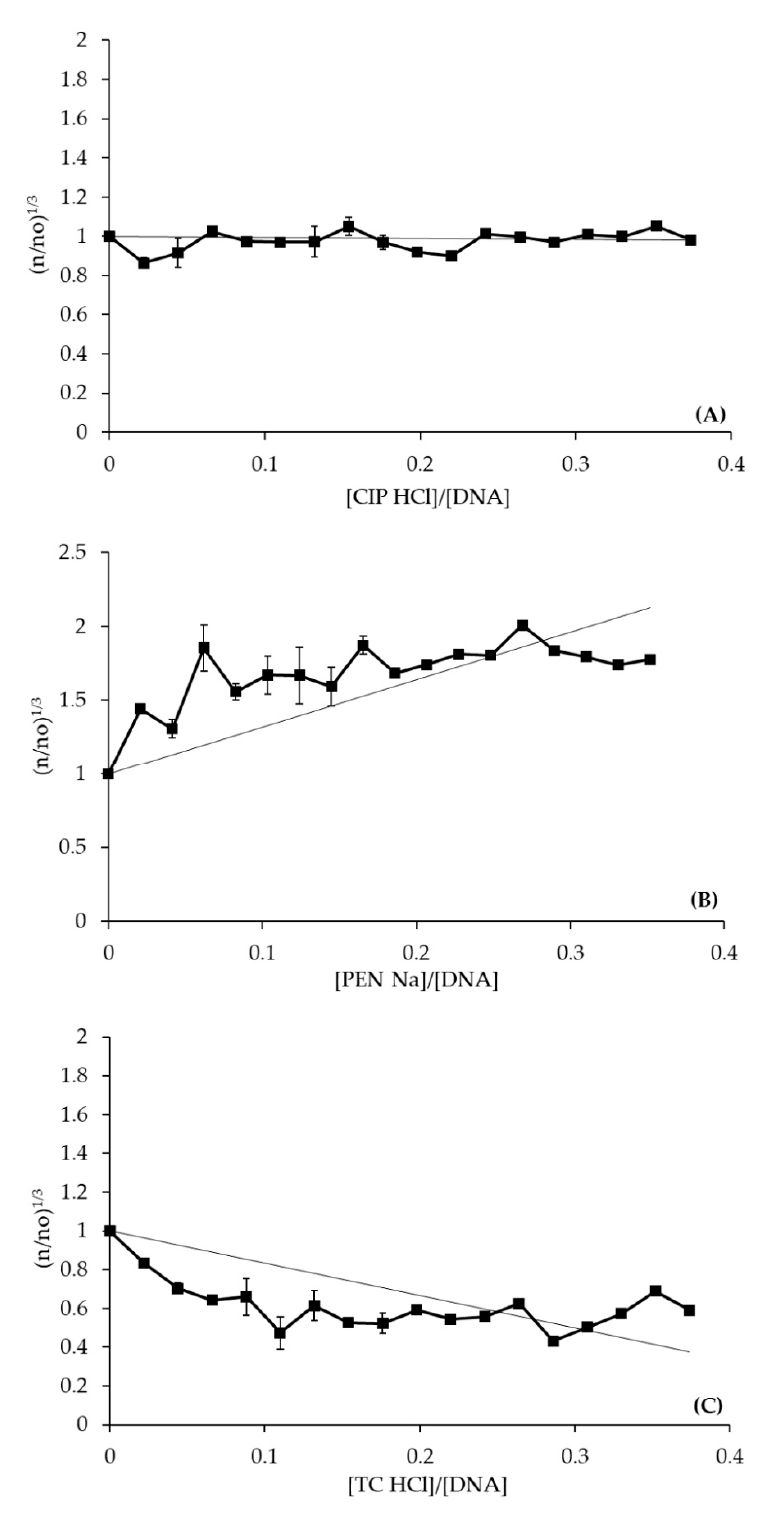
Figure 3. Relative viscosity of CT-DNA with increasing concentrations of ( A ) CIP · HCl (r = 0.37), ( B ) PEN · Na (r = 0.35), ( C ) TC · HCl (r = 0.37) ([DNA] = 10 mM, r = [compound]/[DNA], n is the viscosity of DNA in the presence of the compounds and n o is the viscosity of DNA alone).